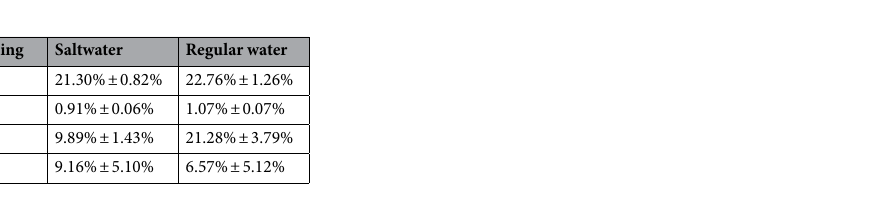
Table 7. Average weight gain by MI, EP, BW, and BR coatings after 28 days if exposition to salt and regular water.